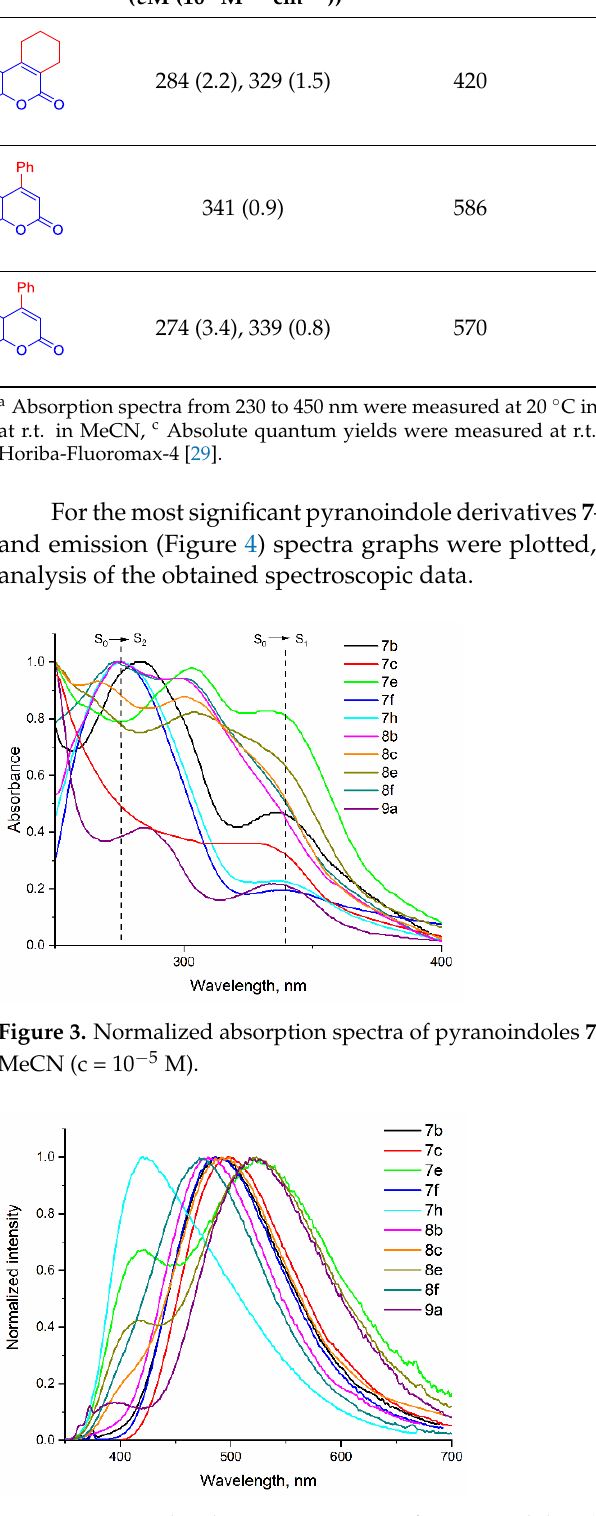
Figure 4. Normalized emission spectra of pyranoindoles 7b – 8b , 7c – 8c , 7e – 8e , 7f – 8f , 7h , and 9a in MeCN (c = 10 − 5 M).